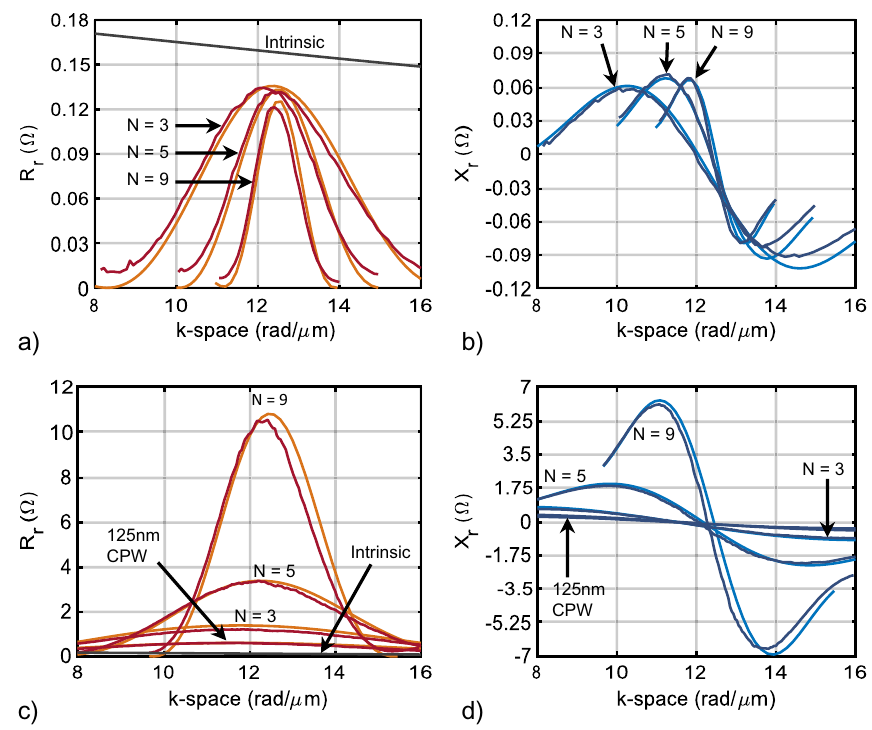
Figure 5. Comparison of the theoretical and FEM radiation impedance for gratings and meander lines as shown in Fig. 3. ( a , b ) Radiation resistance and reactance, respectively, for gratings with various number of elements N . ( c , d ) Radiation resistance and reactance, respectively, for meander lines with various number of elements N . Orange and light blue are the impedances obtained with the theoretical approach, while the dark red and blue were obtained using the numerical approach. Film thickness is 100 nm. A uniform bias of 277 kA/m is applied out-of-plane. The length of the transducers is 10 µ m. The transducers target (cid:31) = 0.5 µ m with a = 0.125 nm and b = 0.5 nm. A CPW line of a = 0.125 nm was also simulated for comparison. The intrinsic resistance is shown for comparison